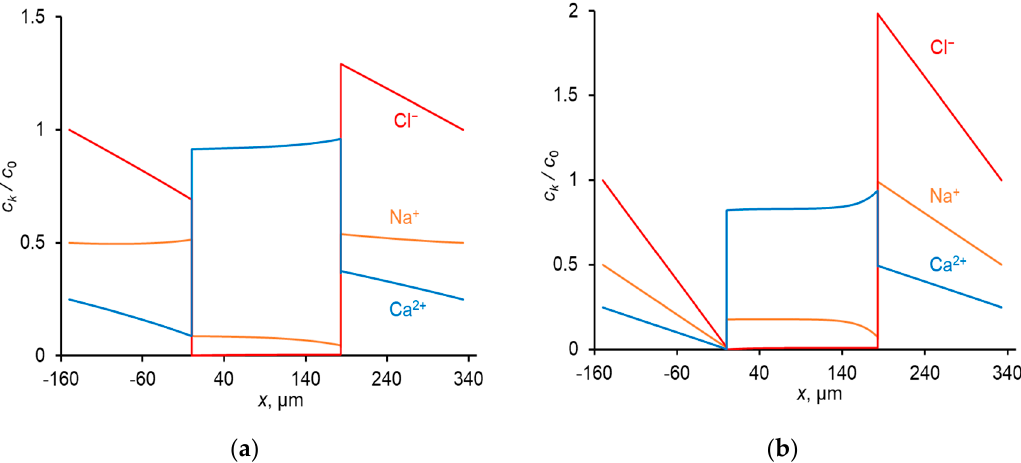
Figure 2. Concentration profiles of ions in CC mode at: U av = 111 mV ( i = 0.3 i lim ) ( a ); U av = 476 mV ( i = i lim ) ( b ). The concentrations are normalized by c 0 ; c 0 = c 0 in the diffusion layers ( c 0 is the concentration of Cl − ions in the bulk solution), and c 0 = Q in the membrane.